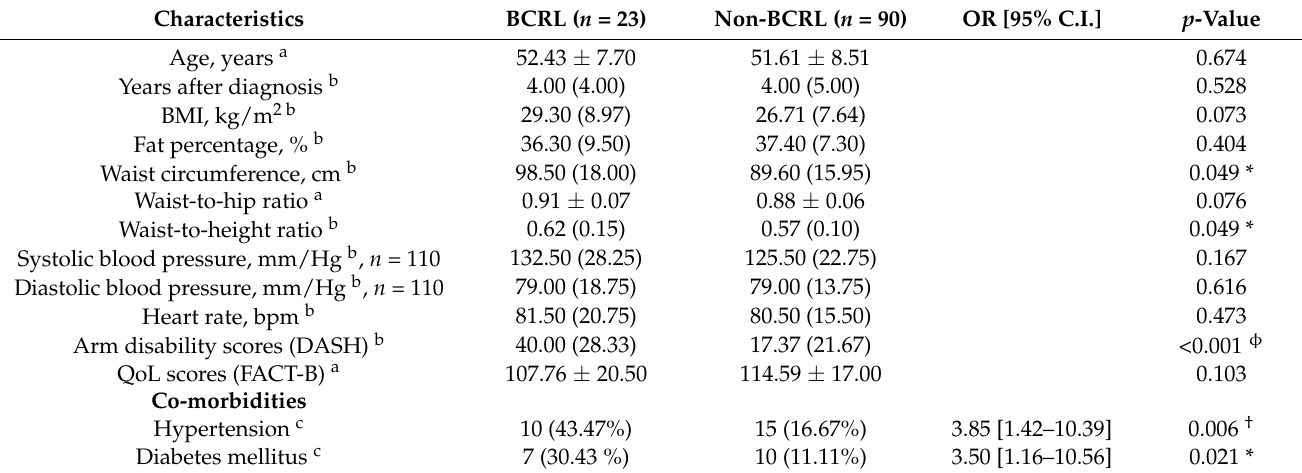
Table 1. Characteristics of the participants for the combined